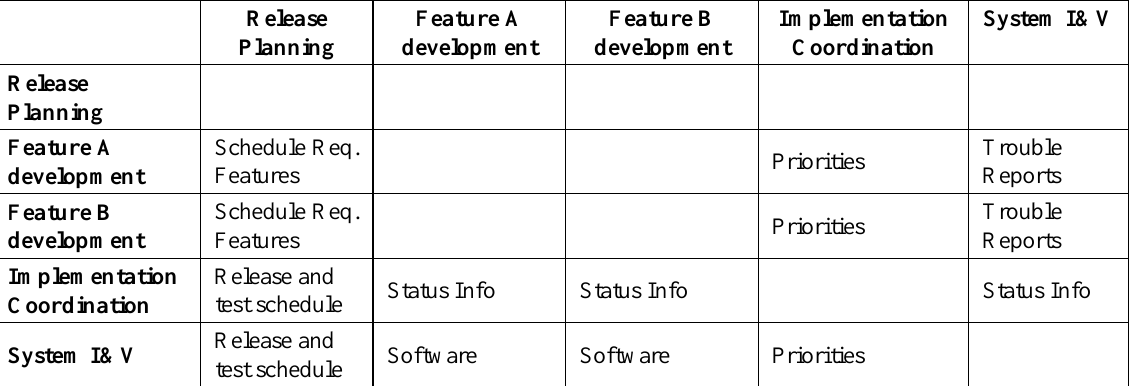
Table 2. A fragment of the output-input matrix for Figure